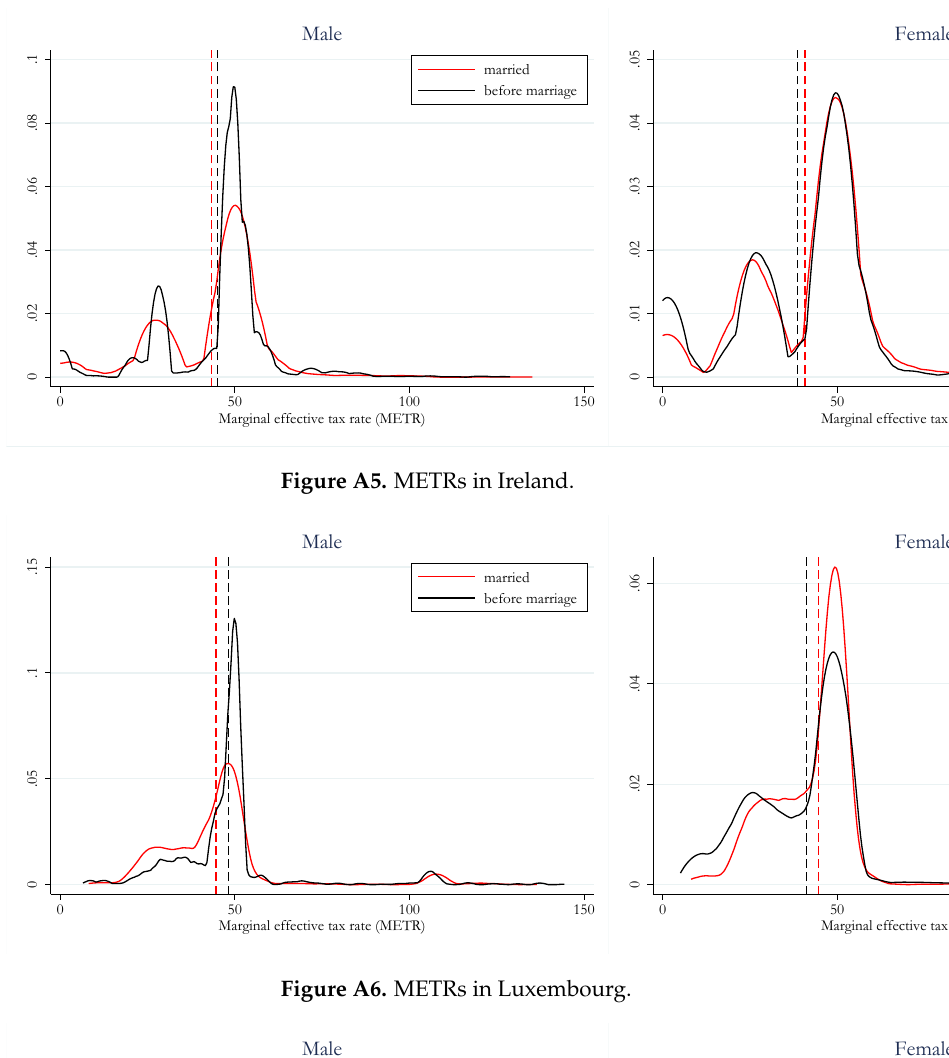
Figure A6. METRs in Luxembourg.